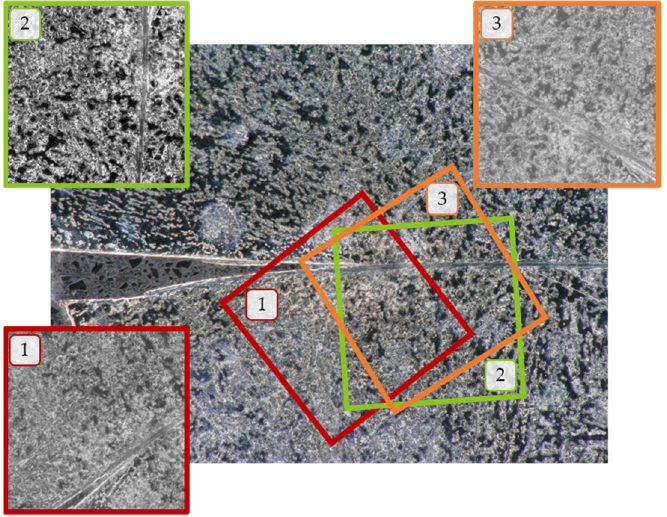
Figure 3. Microscopic image of a shear band of a sheared specimen with generated patches for machine learning.